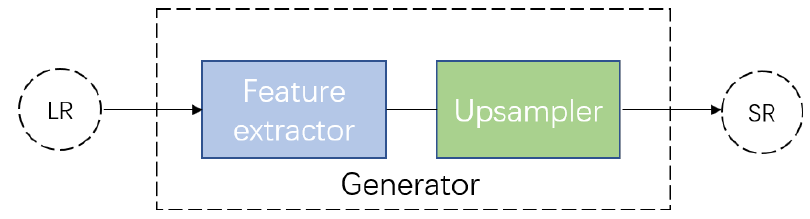
Figure 3. The architecture of our